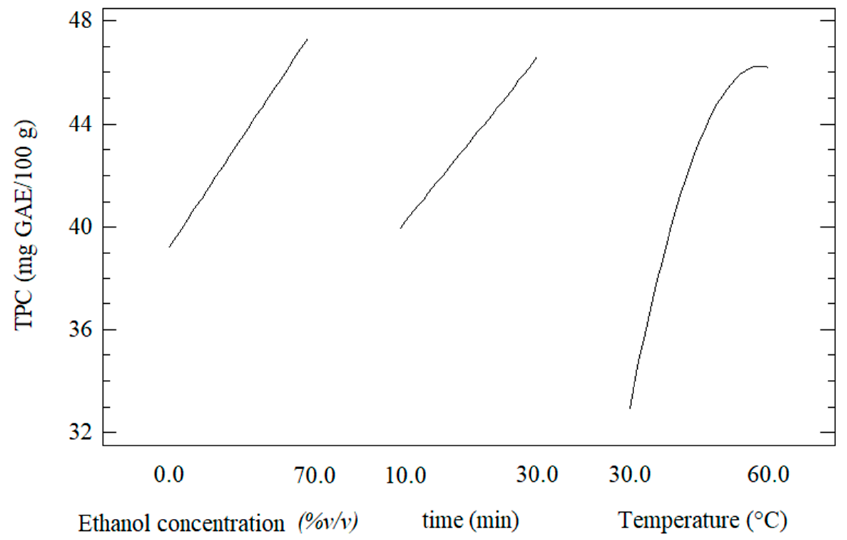
Figure 2. Effect of the individual variables process on the total polyphenols content (TPC) of the extracts from Welsh onion leaves. Table 2. Analysis of variance (ANOVA) for total phenolic